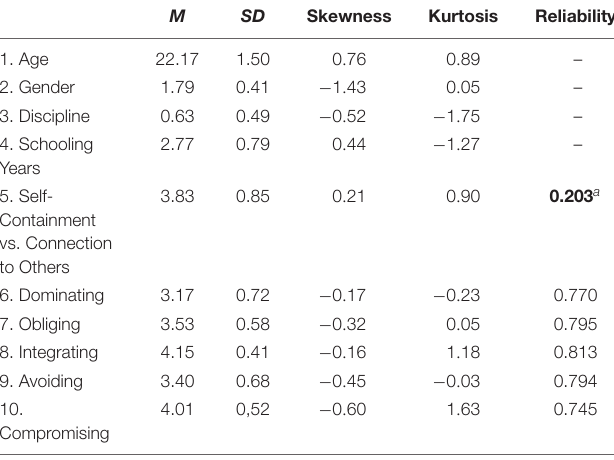
TABLE 2 | Descriptive statistics for the variables in Study 2.